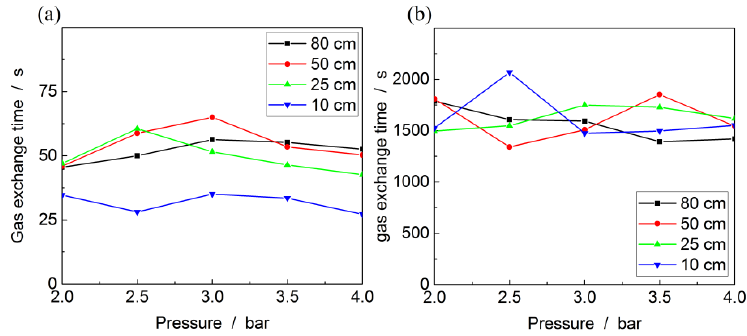
Figure 5. Gas exchange times of ( a ) kagomé-PCF and ( b ) PBG-PCF at lengths of 0.1 m, 0.25 m, 0.5 m and 0.8 m. Please note the different scales on the y -axis.